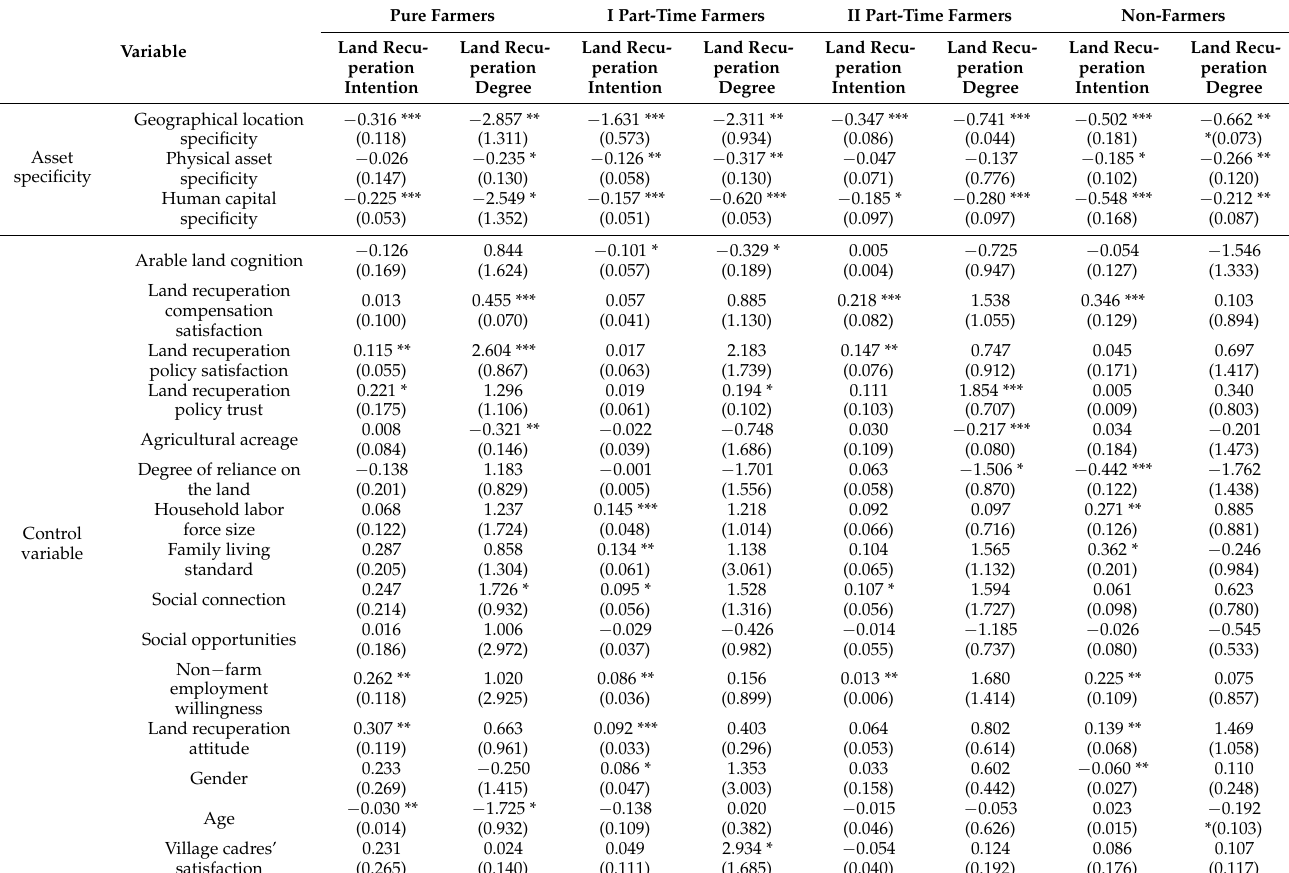
Table 8. Ordinary least squares regression